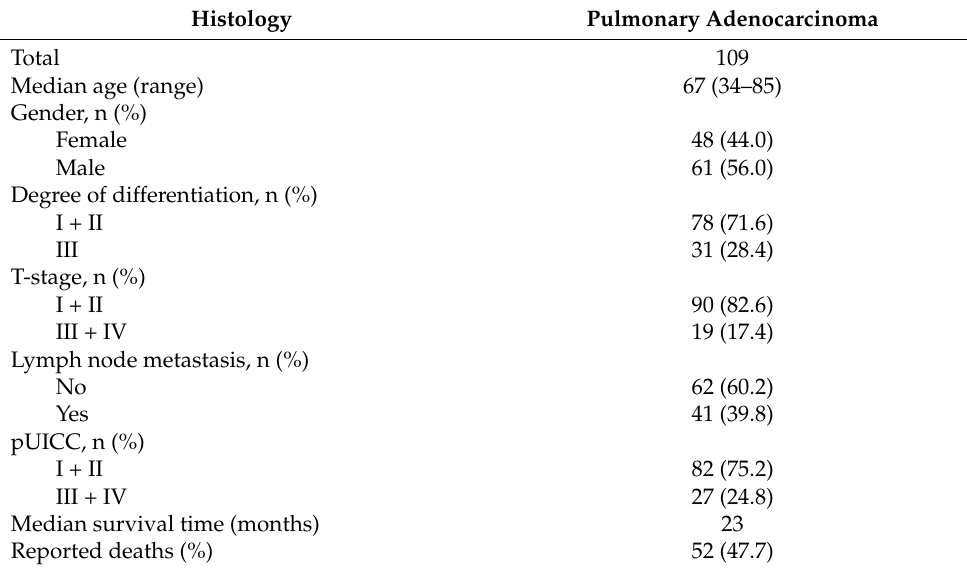
Table 1. Clinical data